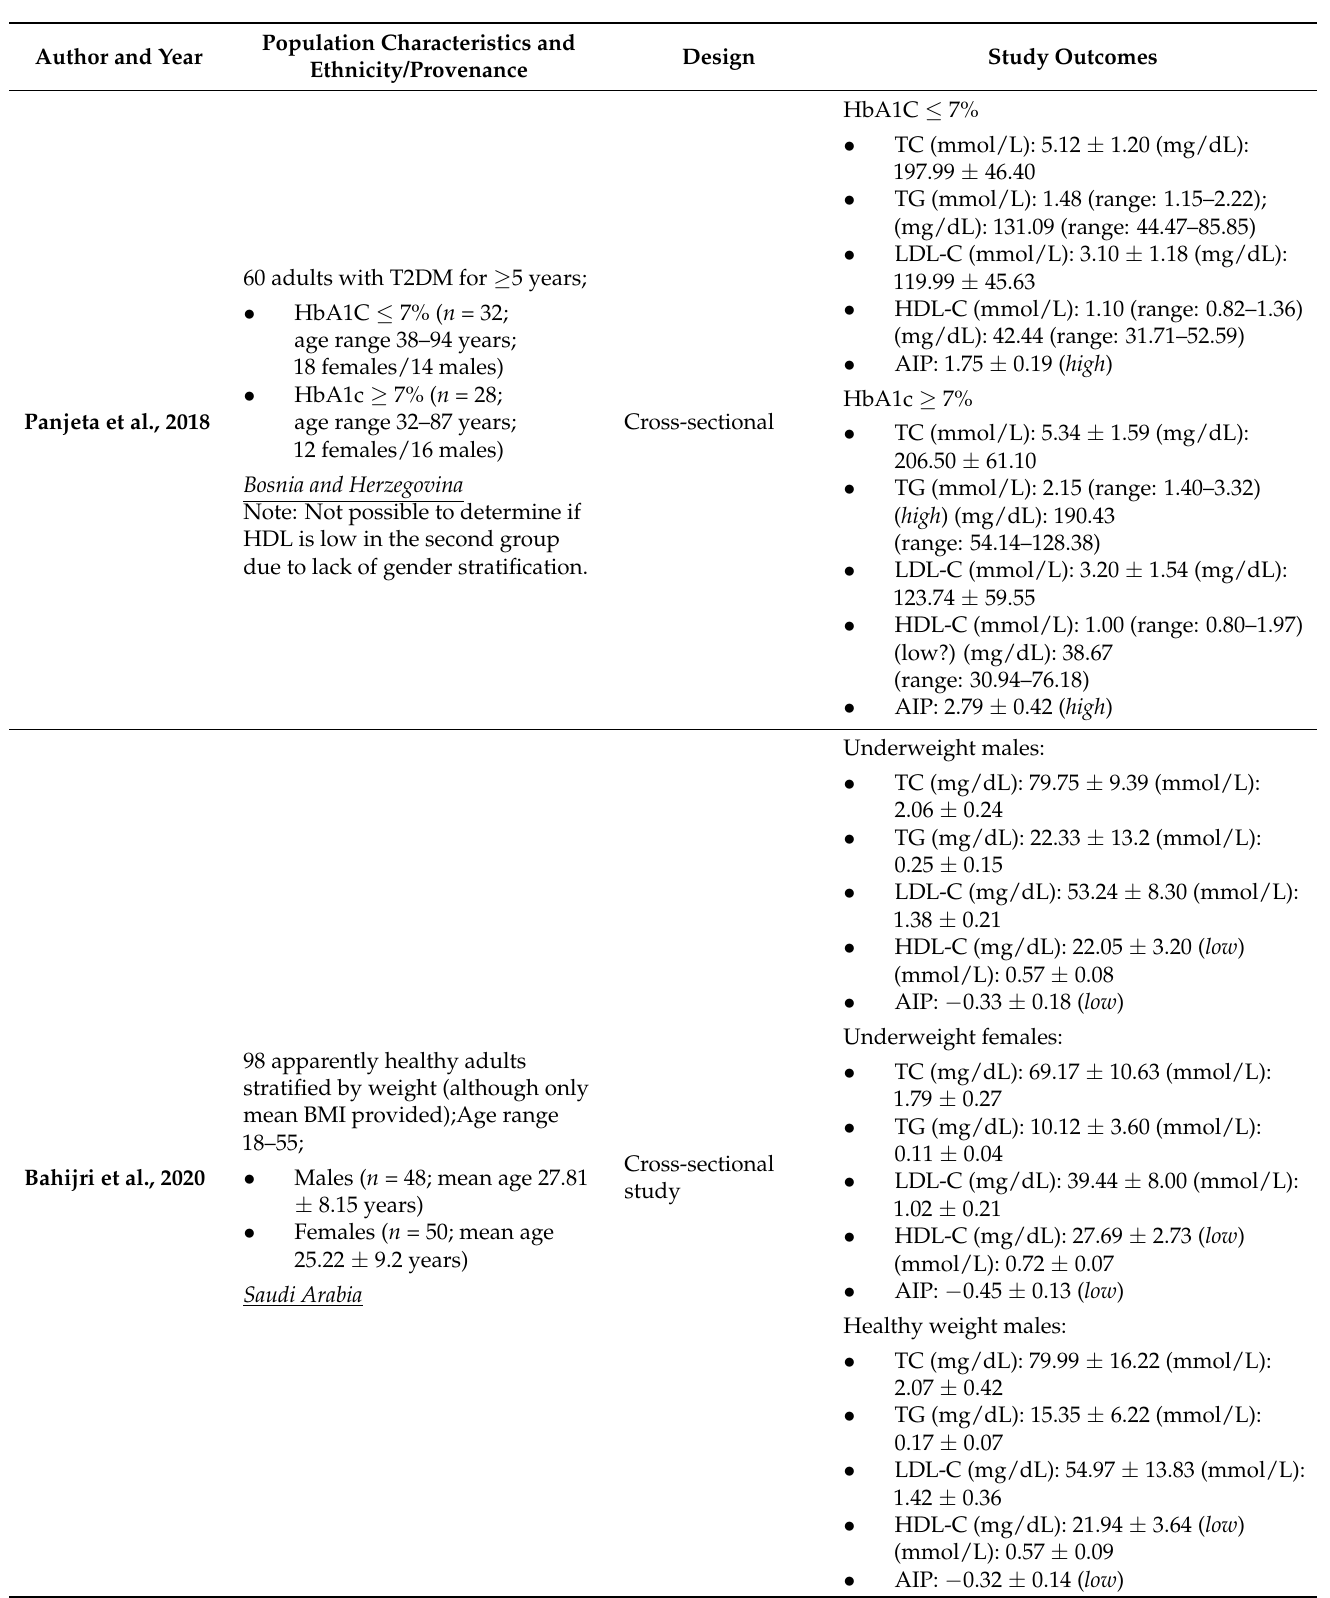
Table 4. Outline of the studies interlinking blood lipid markers and AIP. Author, year, subject characteristics, study design, primary outcomes, and other study outcomes of interest (TC, TG, LDL-C, HDL-C) are presented for each study where available